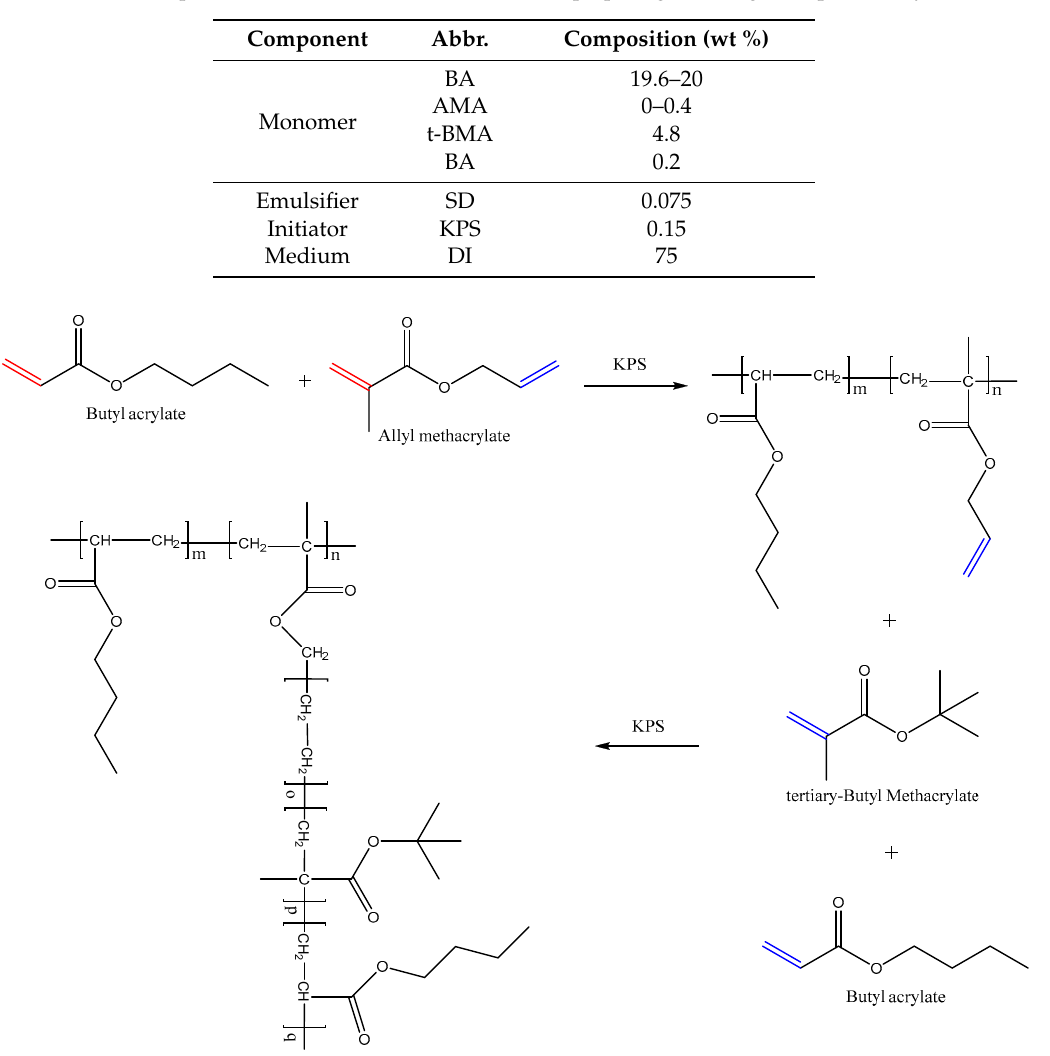
Scheme 1. Pathway for the preparation of the acrylic polymer resins.